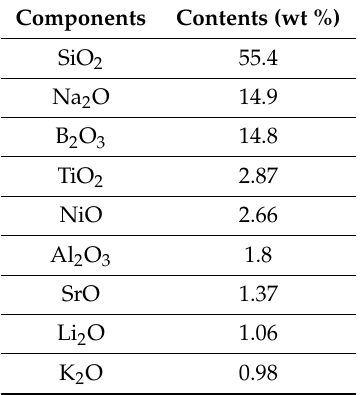
Table 1. Chemical composition analysis of enamel used in this study.